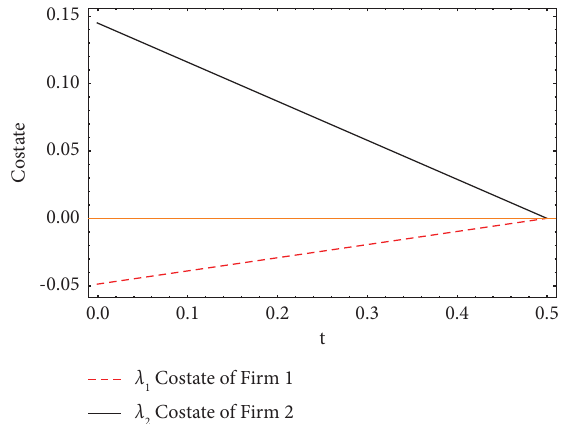
Figure 4: Te costate variables of frm 1 and frm 2 and the time t